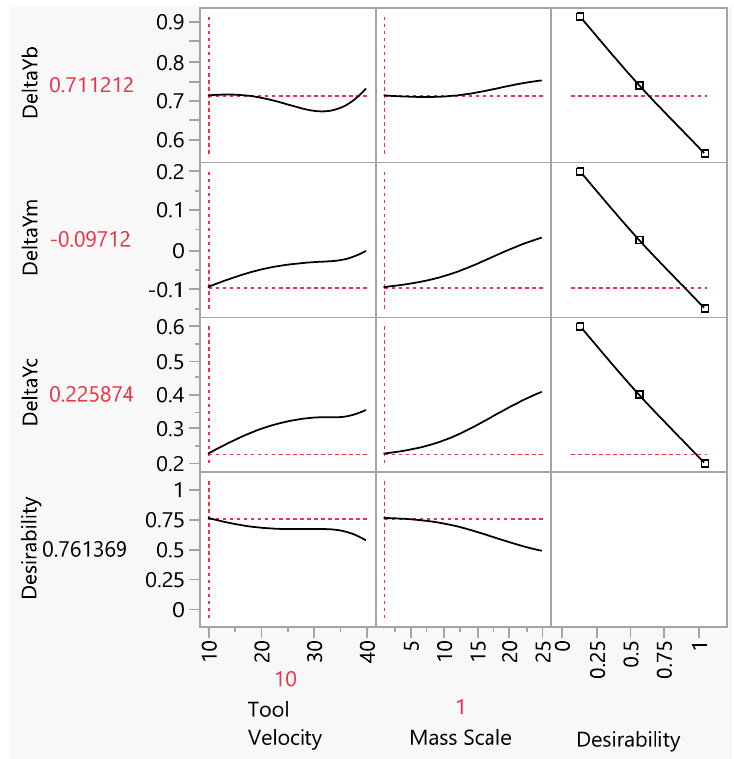
Figure 15. Profiler plot with optimized values for mesh size 3 × 3 mm.